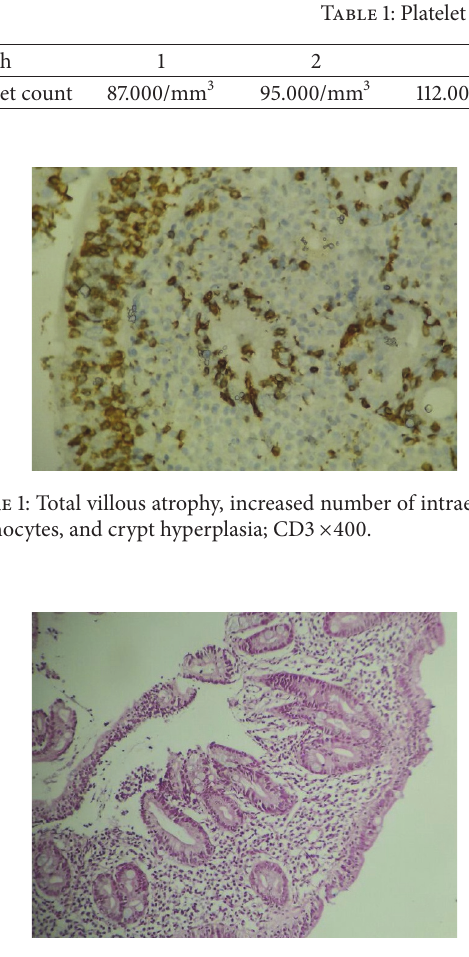
values (183.000/mm 3 ) in the fifth month of the diet (Table